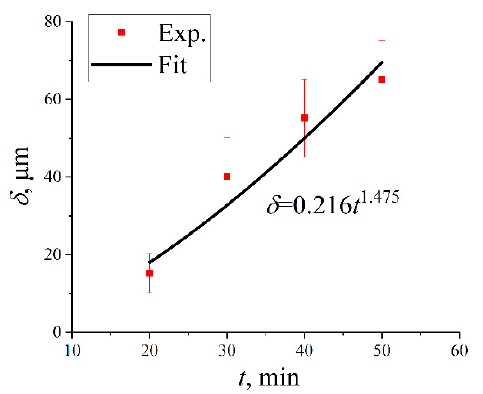
Figure 3. The growth kinetics curve of the Ti(Al,Si) 3 alloy layer.